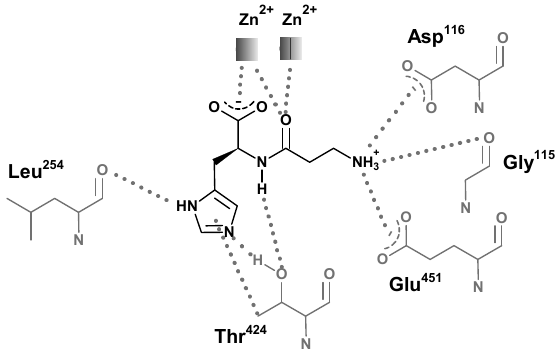
Figure 9. Structural representation of the simulated interaction pattern between human serum carnosinase CN1 and carnosine. The enzyme would bind the ammonium group, the carboxylate group, and the unsubstituted imidazole ring. The amido bond is simultaneously bound for recognition and polarized for catalysis